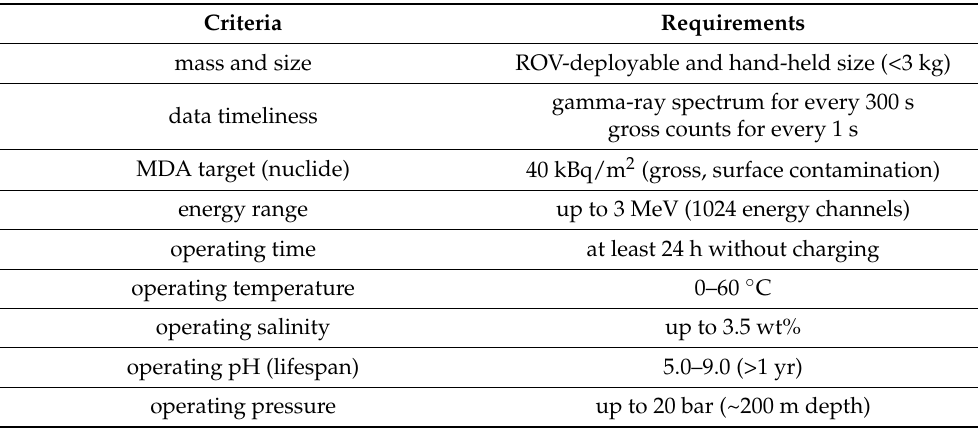
Table 1. Design objective of the underwater gamma-ray sensor.